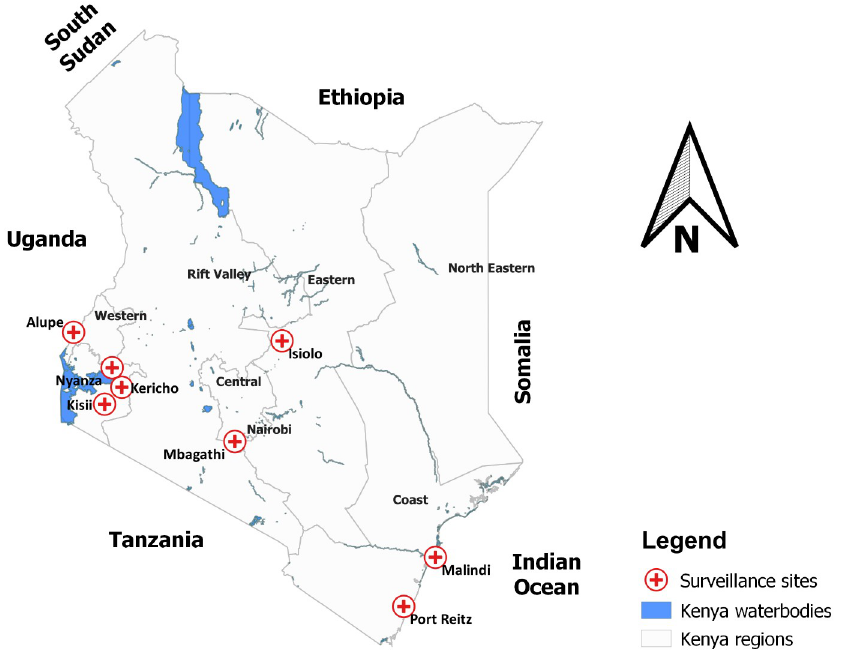
Fig 1. Influenza and other respiratory viruses program surveillance